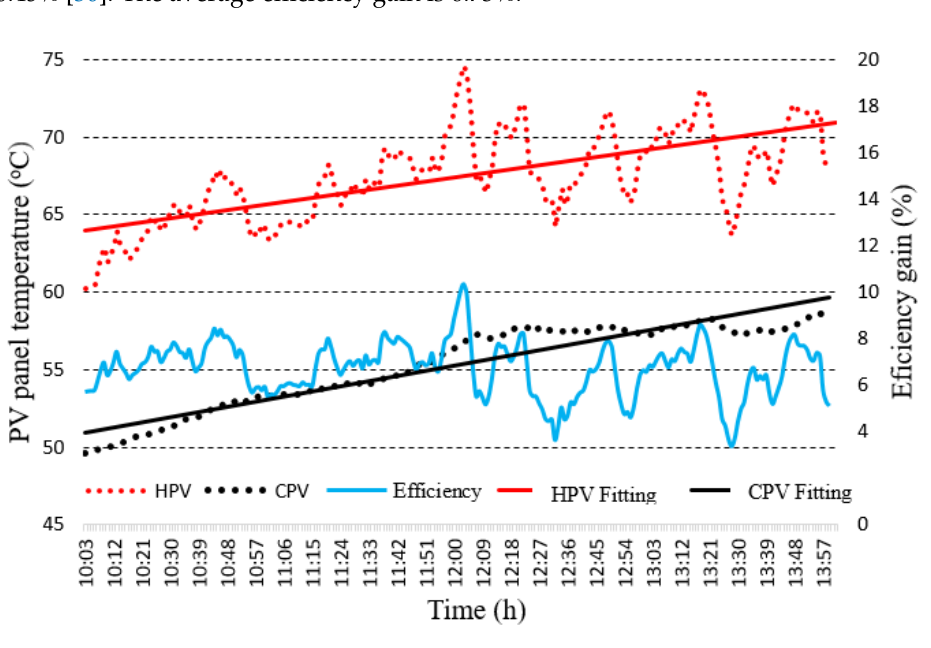
Figure 8. Efficiency gain because of cooling.